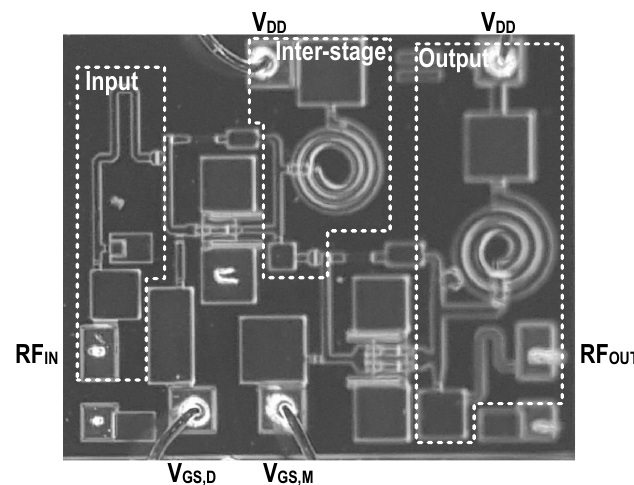
Figure 6. Overall schematic diagram of the proposed broadband PAIC. Figure 7 shows the measurement results of the proposed 6 to 18 GHz GaAs pHEMT broadband PAIC. Figure 7a shows the measured S-parameters of the PAIC. For the 6 to 18 GHz band, S21 of 17.2 dB at 15 GHz, S11 of − 9.15 dB or less, and S22 of − 10.03 dB or less were measured. The flatness of S21 was ± 1.1 dB in the band. The term ’flatness’ can be defined for gain and output power in the given frequency band as follows maximum value − minimum value f latness = ±